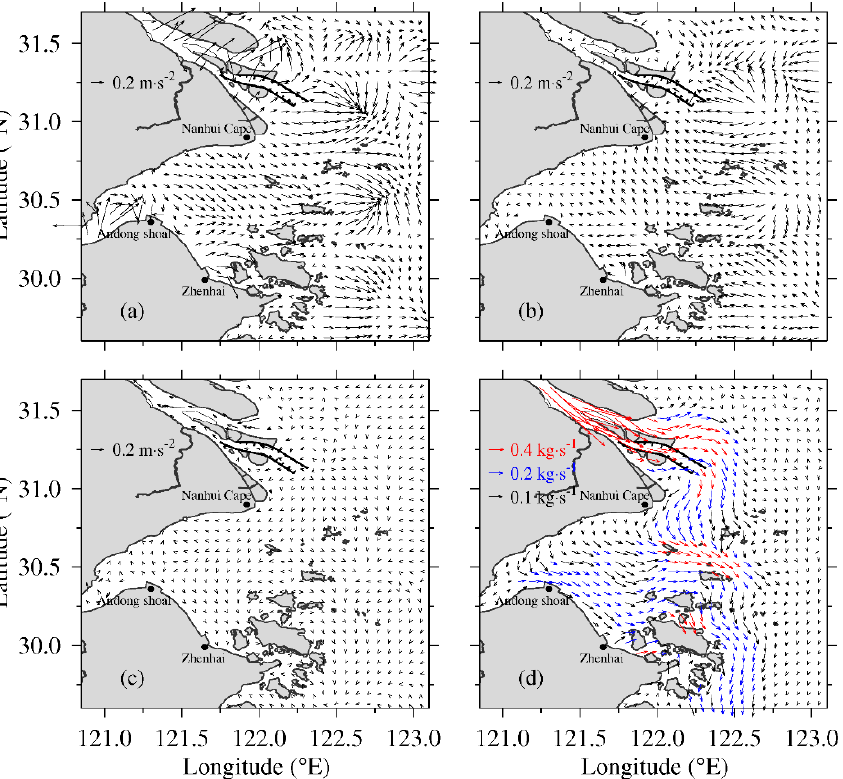
Figure 17. Distribution of tidally averaged barotropic pressure gradient force ( a ), vertically averaged baroclinic pressure gradient force ( b ), resultant force of wind stress and bottom friction ( c ), and the RUSF in the whole layer without baroclinic pressure gradient force ( d ) during neap tide in summer.